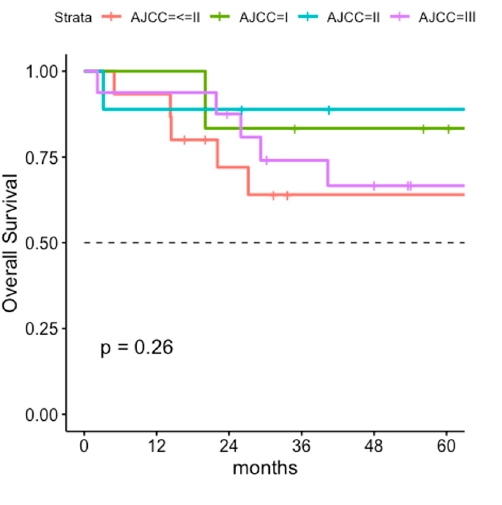
Figure A2. ( a ) Stage-adapted OS and ( b ) PFS of the total cohort for stage I-II and stage III, according to AJCC-staging classification (n = 57).